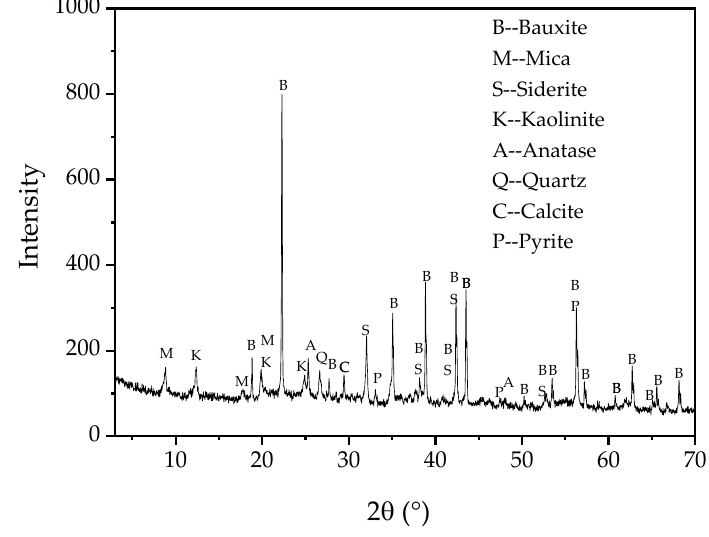
ff raction pattern of the bauxite Figure 1. X-ray diffraction pattern of the bauxite ore. Figure 1. X-ray di